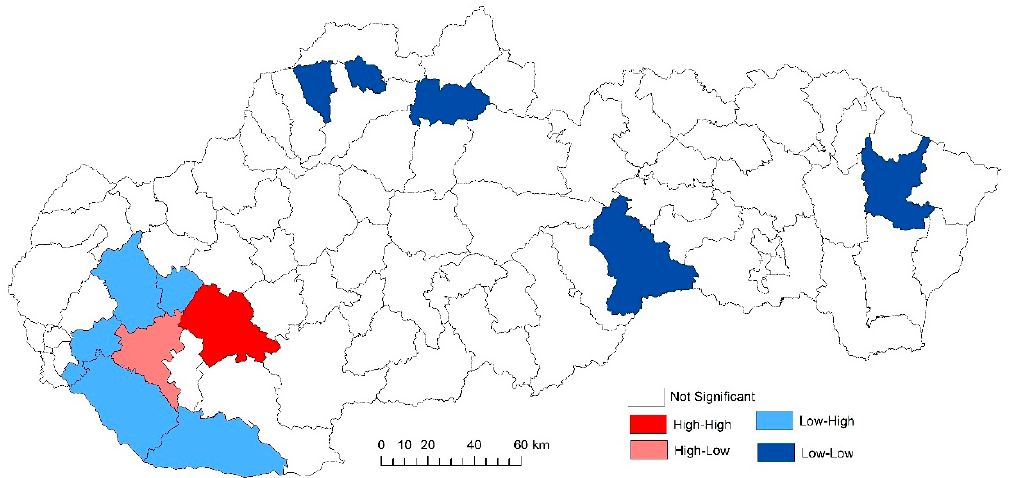
Figure 6. Reginalization of Slovakia based on the LISA analysis for standardized death rate of breast cancer per 1000 inhabitants of European Standard Population, 2013–2018. Source: Statistical Office of the Slovak Republic, 2019.